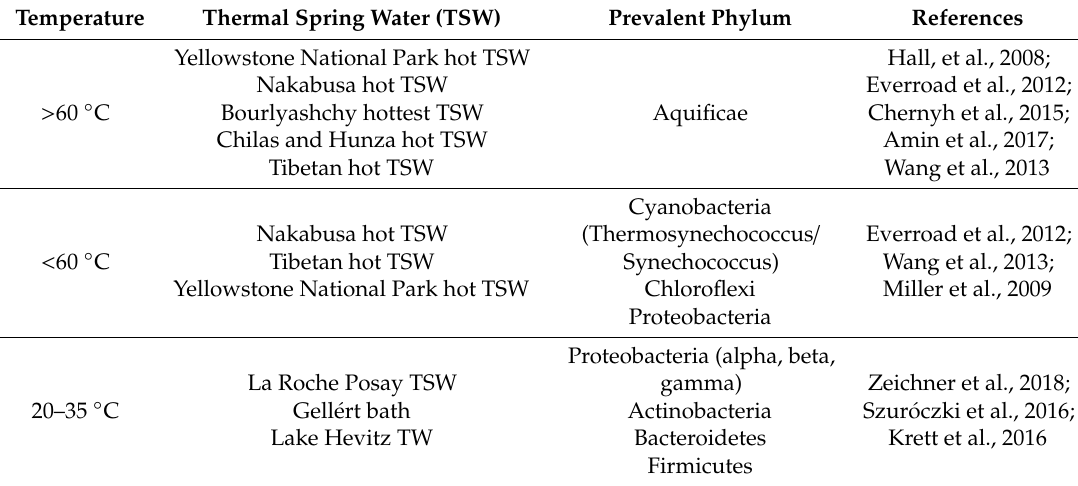
Table 3. Prevalent bacterial phyla in thermal spring water based on temperature